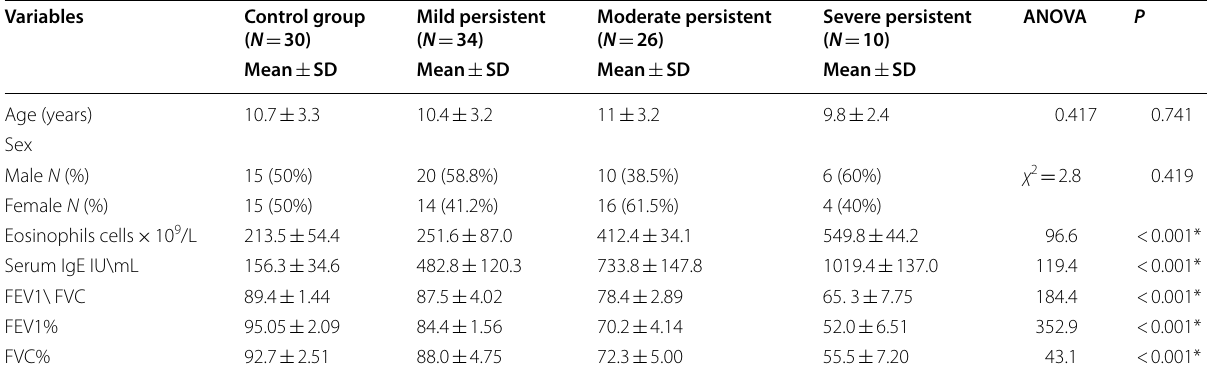
Table 2 Global subject characteristics